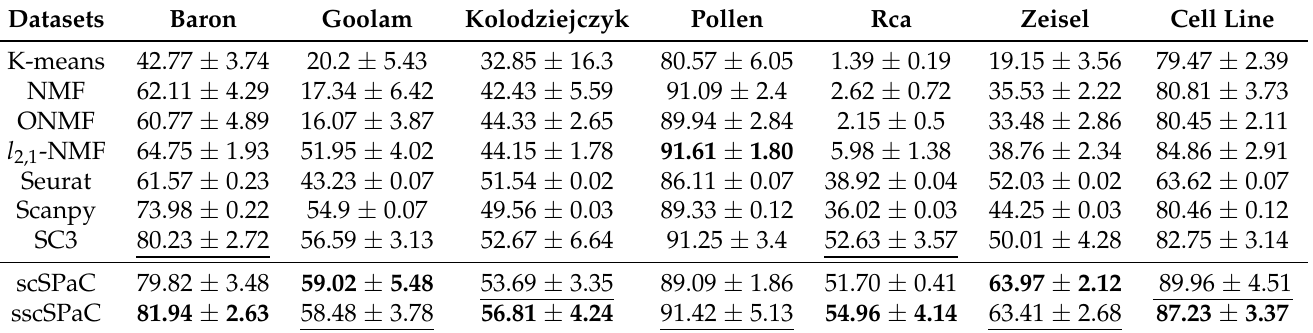
Table 5. Clustering results for NMI on real scRNA-seq data. The highest score for each dataset is shown in bold and the second best score is